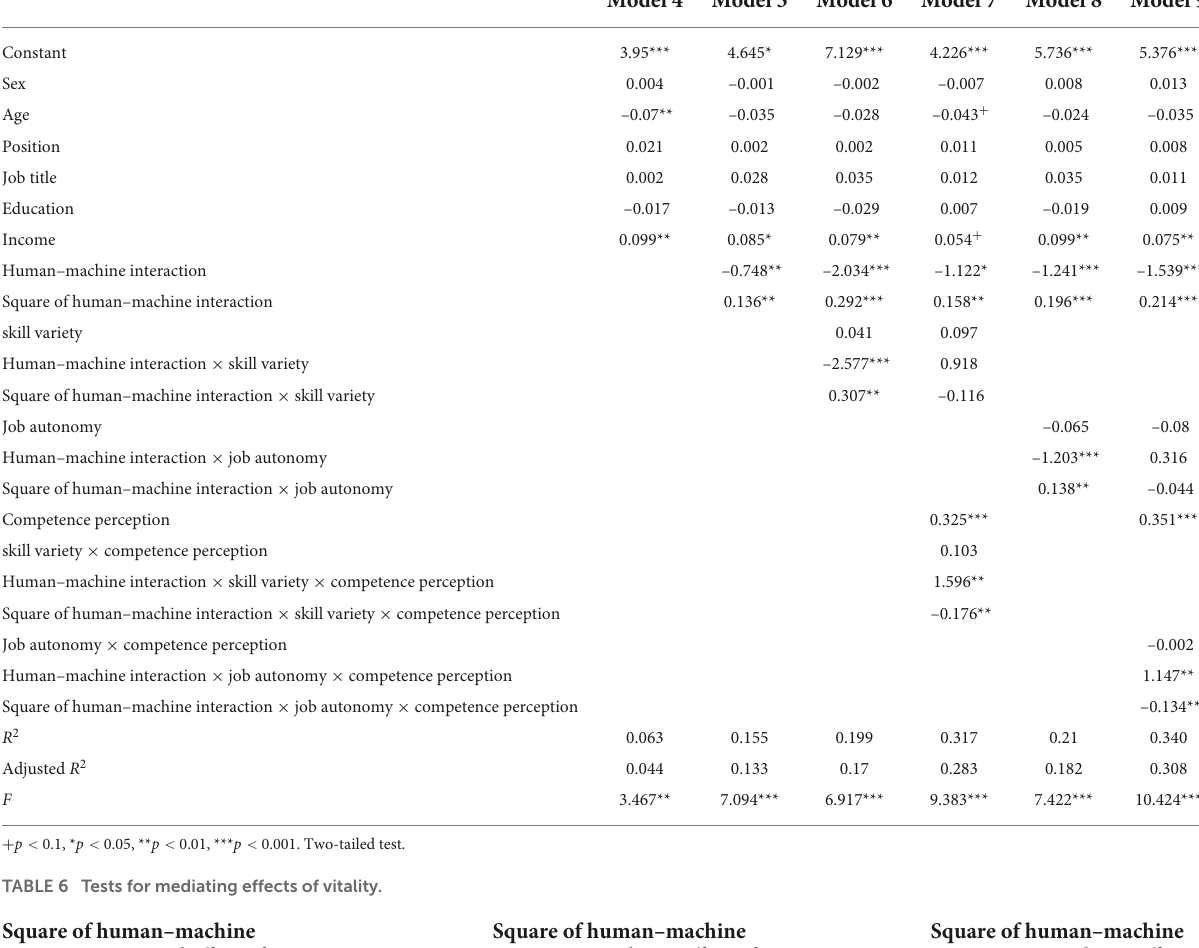
TABLE 5 Results of the analysis of mediating and moderating effects.